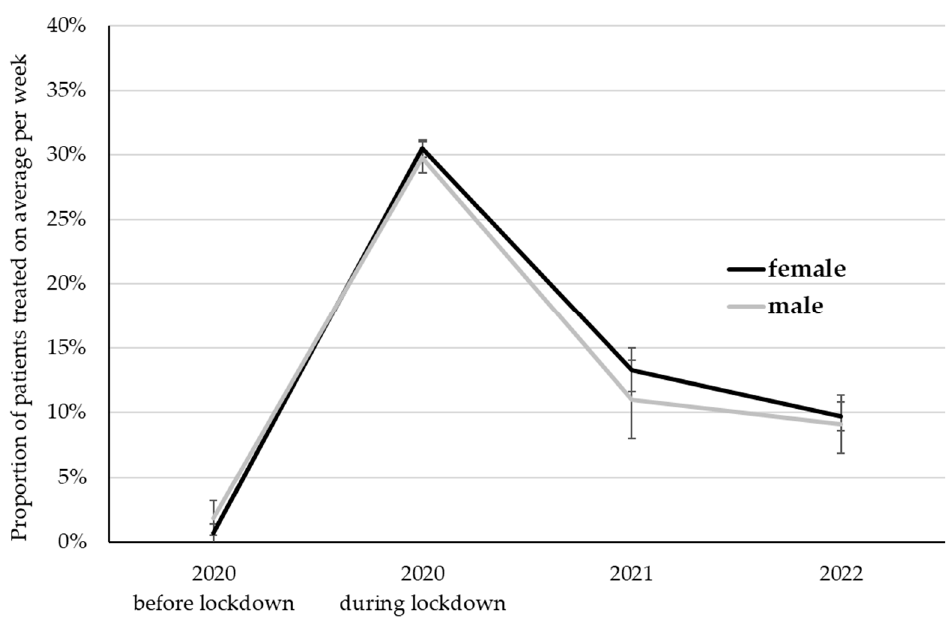
Figure 3. The proportion of patients treated on average per week via the internet. LS Mean ± standard error.